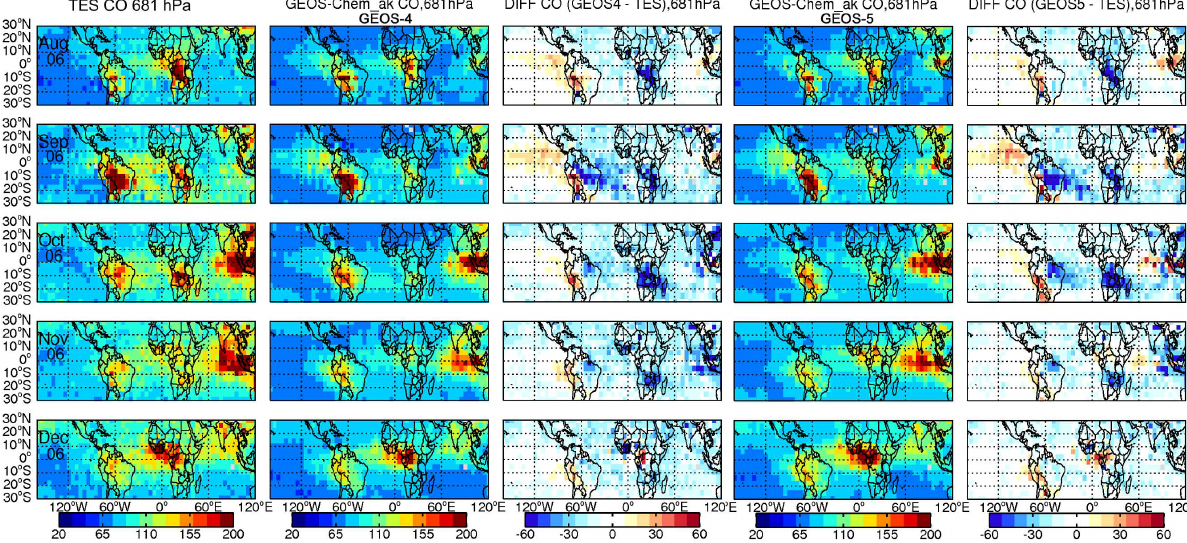
Fig. 4. Lower tropospheric CO at 681hPa from August 2006 to December 2006 from TES (left column), the GEOS-4 model, and the difference (model wAK–TES) (2nd and 3rd columns), the GEOS-5 model, and the difference (model wAK–TES) (4th and 5th